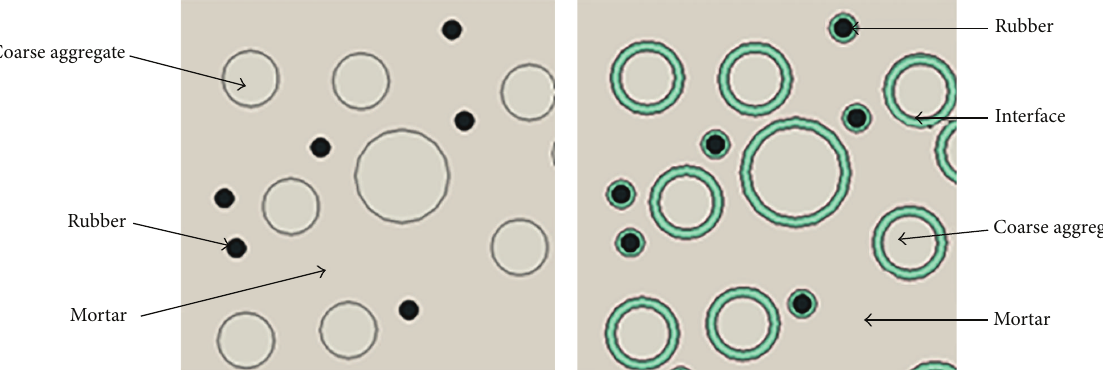
Figure 2: Element material property